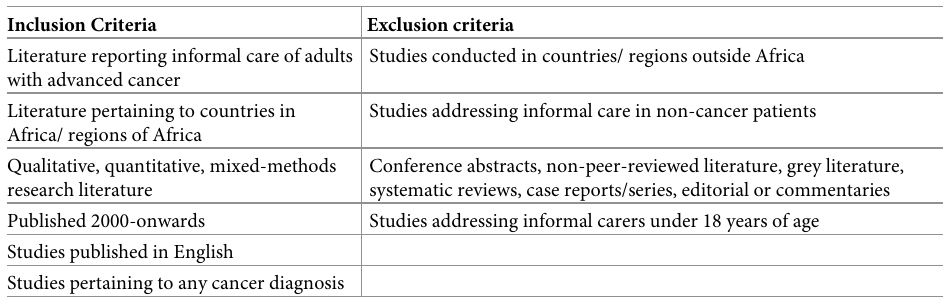
Table 1. Inclusion and exclusion